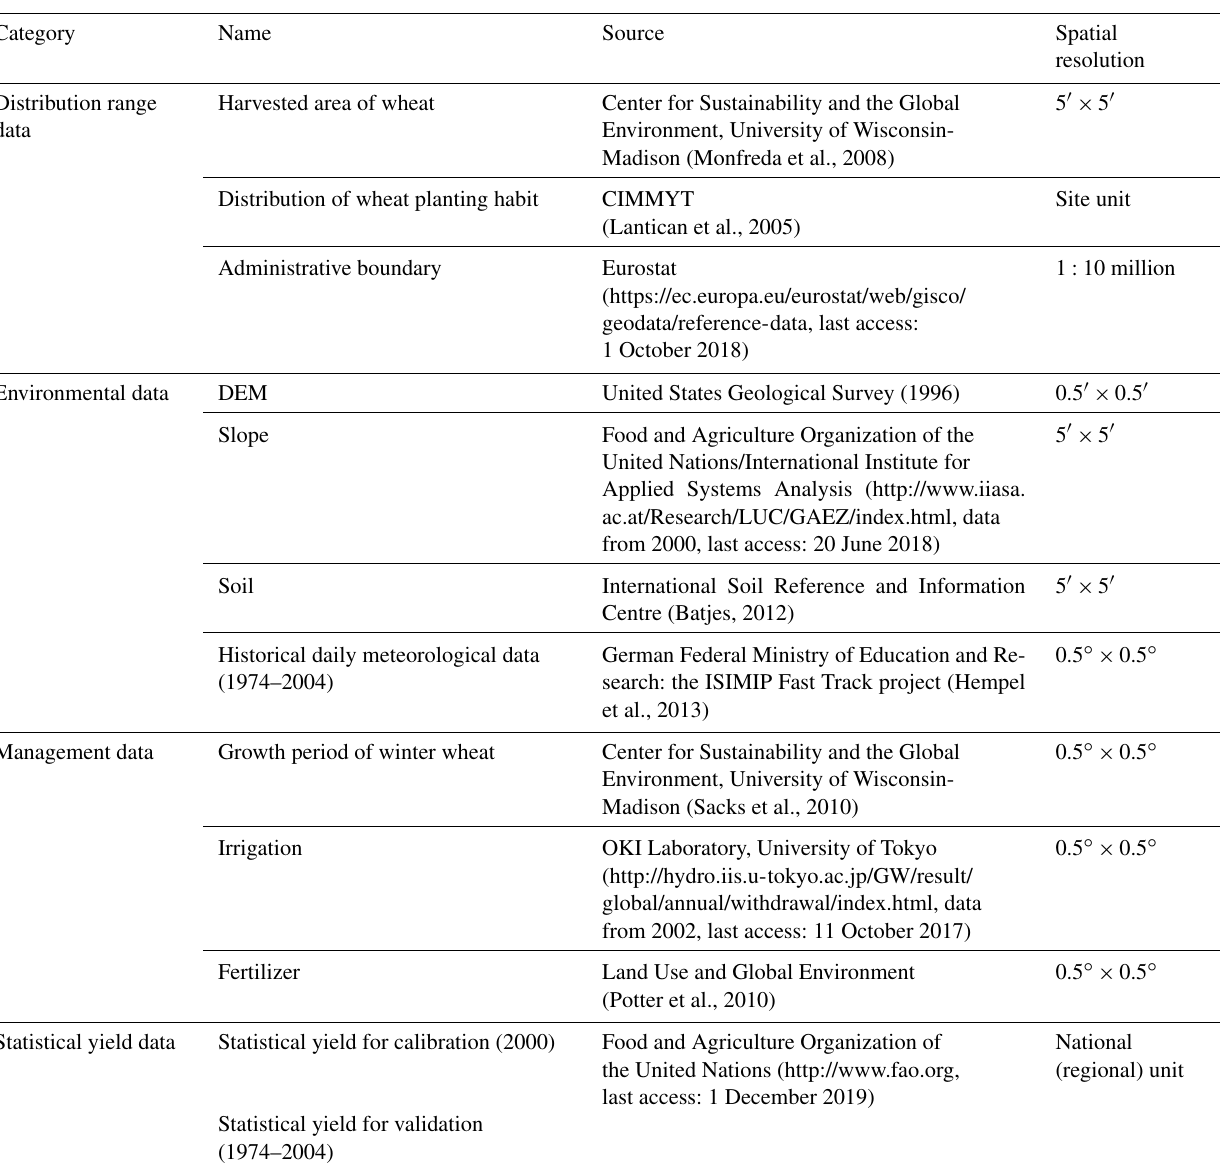
Table 1. Basic database. Category Name Source